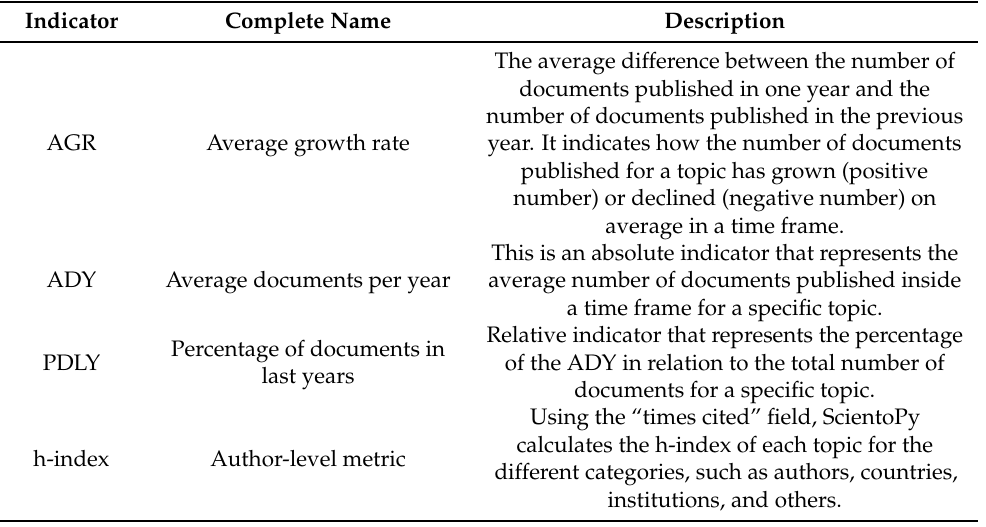
Table 1. Topic growth